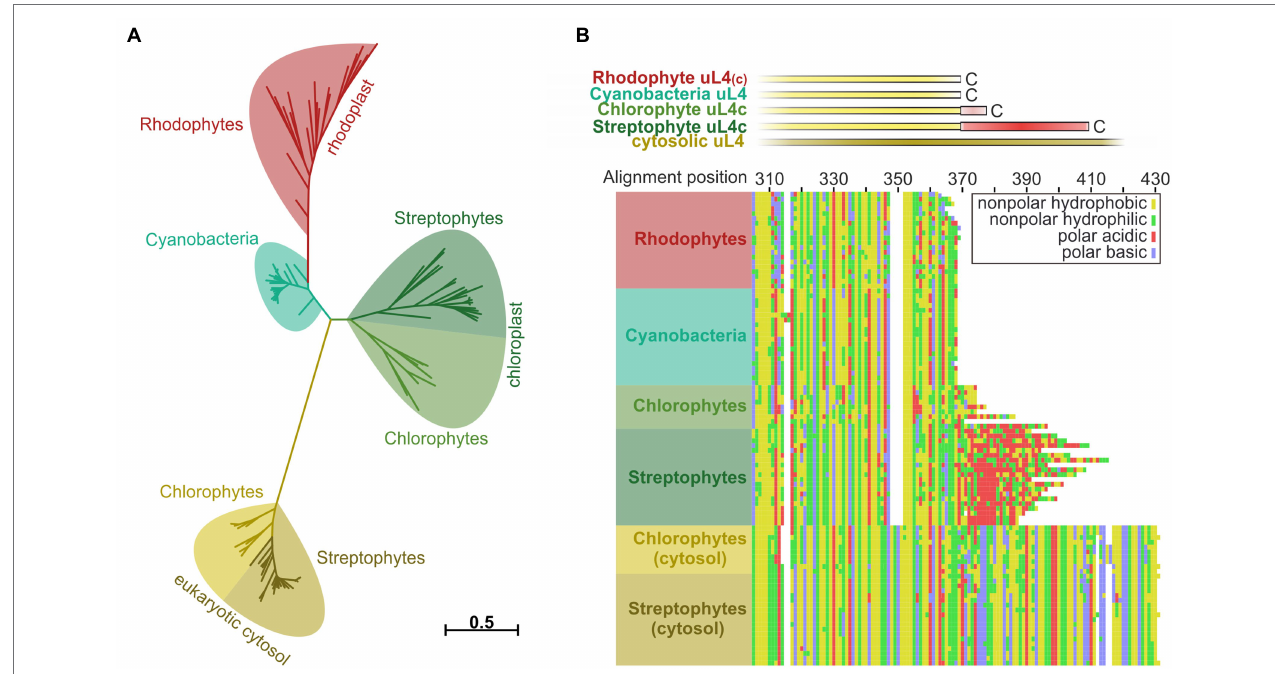
FIGURE 5 | Reconstruction of phylogenetic relationships and amino acid sequence comparisons between uL4 proteins of photosynthetic organisms. Phylogeny- and multiple sequence alignment-based analysis of plastidic and cytosolic uL4 sequences from chlorophytes, streptophytes, rhodophytes, and cyanobacteria. (A) Unrooted maximum likelihood tree of the homologous uL4 peptide sequence regions. Branch lengths are scaled according to the number of substitutions per site. (B) MAFFT alignment of the uL4 amino acid sequences, using the L-INS-I algorithm. Top: schematic representation of the aligned sequences. Bottom: Cropped alignment emphasizing the C-terminal regions of the bacterial/plastidic uL4/uL4c proteins. Amino acids are represented by their chemical properties: non-polar hydrophobic (yellow; A,F,I,L,M,P,V,W), non-polar hydrophilic (green; C,G,N,Q,S,T,Y), polar basic (blue; H,K,R) and polar acidic (red;